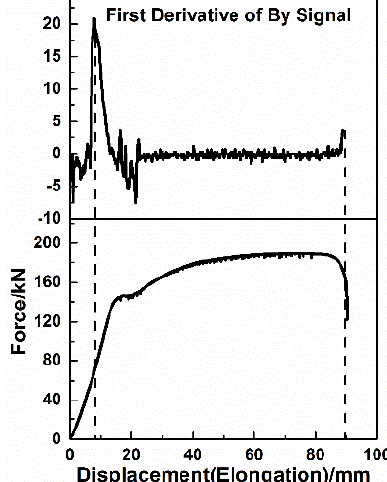
Figure 7. Variation of first derivative of the By signal, and tension–displacement curve of the Φ 20–C40–1 specimen during the loading process.